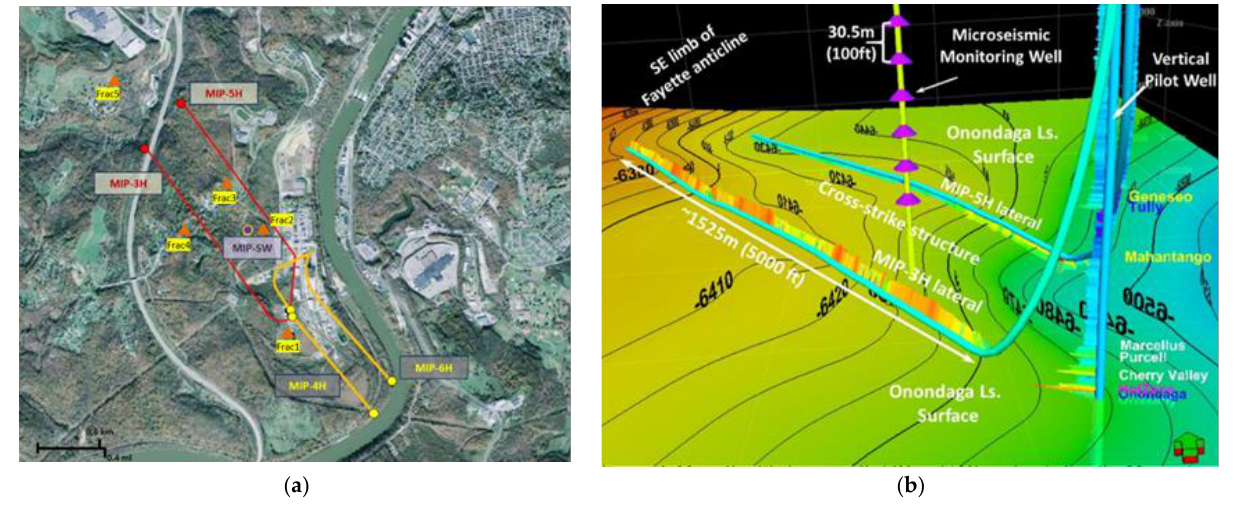
Figure 2. Surface and subsurface information about the MSEEL project. ( a ) The surface location of the site. The field is located next to the Monongalia River in Morgantown, WV. It consists of four horizontal wells, one microseismic monitoring well (the dot between wells MIP-3H and MIP-5H), and five surface seismic stations (yellow dots). ( b ) Location and direction of the two wells used in this study. Figures adapted from [25].